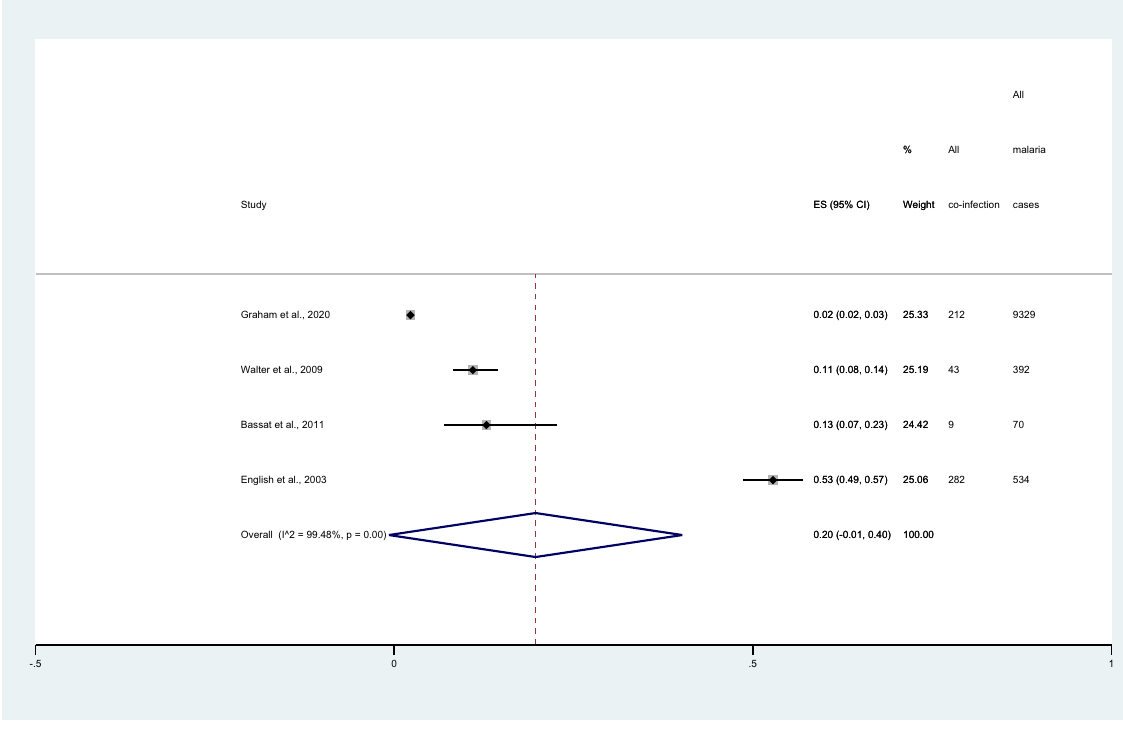
Figure 5. Forest plot demonstrates the pooled proportion of severe pneumonia among patients with malaria. ES, prevalence estimate; CI, confidence interval.